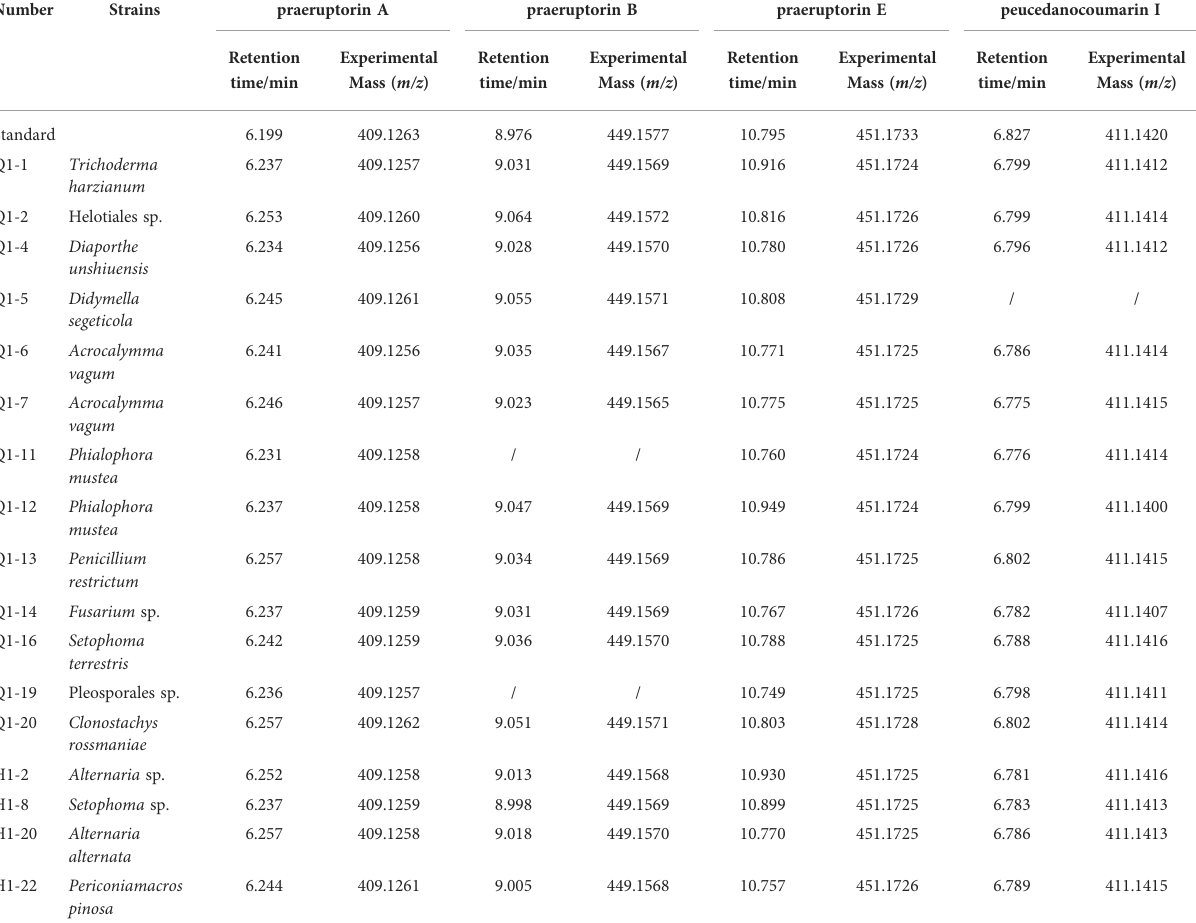
TABLE 1 Coumarins in endophytic fungus of